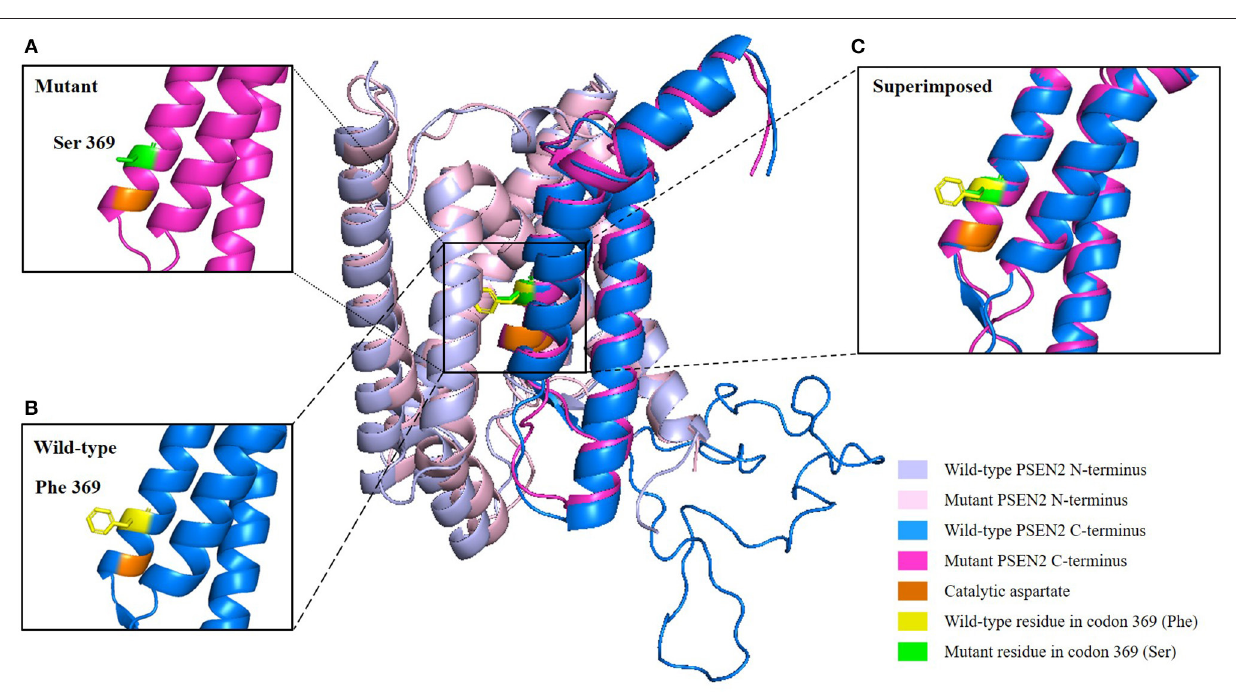
FIGURE 3 | 3D structure prediction of the PSEN2 p.Phe369Ser mutation. Wild-type PSEN2 N-terminus: light blue; mutant PSEN2 N-terminus: light pink; wild-type PSEN2 C-terminus: marine blue; mutant PSEN2 C-terminus: magenta. Catalytic aspartate on transmembrane domain 7 is colored orange. Wild-type and mutant residues in position 369 of PSEN2 are highlighted in yellow and green, respectively. (A) Zoomed-in view of the mutant PSEN2 C-terminus. (B) Zoomed-in view of the wild-type PSEN2 C-terminus. (C) Zoomed-in view of the superimposed wild-type and mutant PSEN2 C-terminus, which displayed substitution of phenylalanine by serine at codon 369